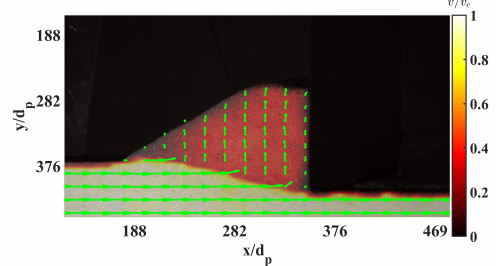
Figure 2. Velocity field obtained from PIV. The present image corresponds to a time instant when the tool has moved by a distance of 5*D, D being the initial depth of cut